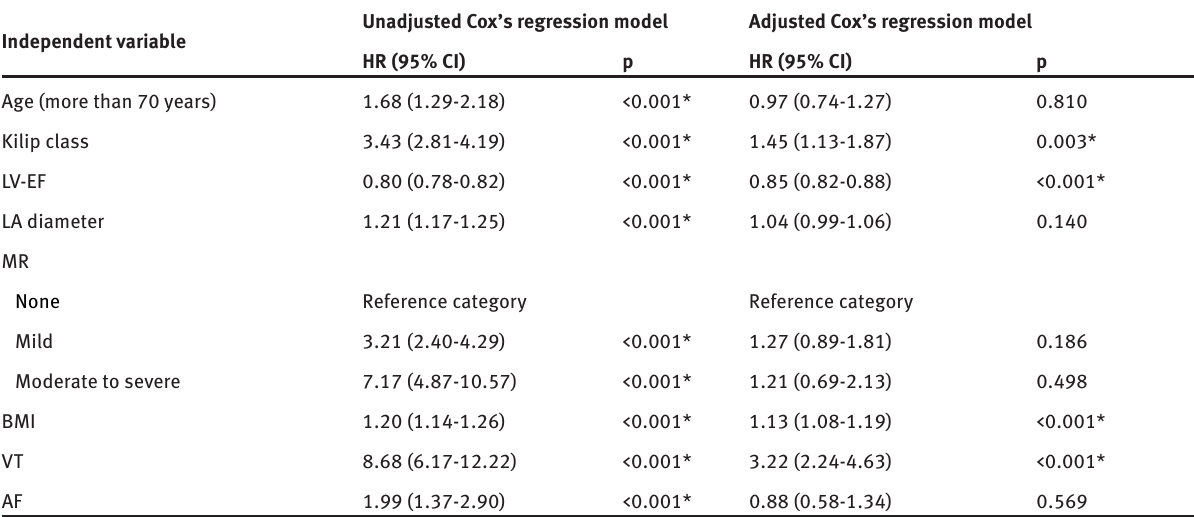
Independent variable